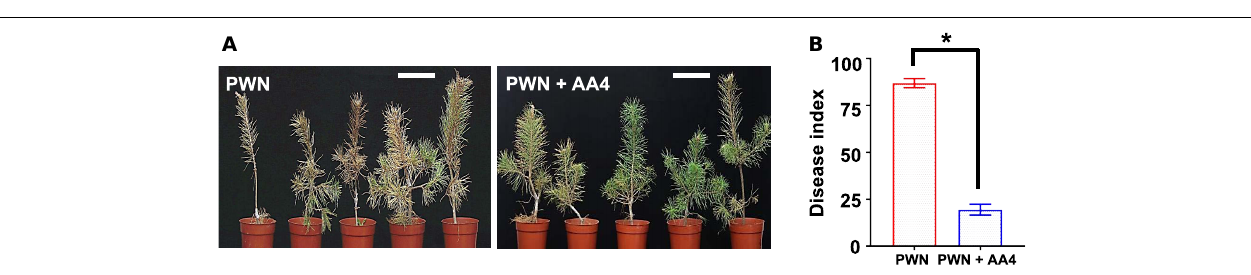
We next created a knock-out mutant of the sdaB gene by employing the Red ( λ , β , exo)-mediated DNA homologous recombination system. The L -serine hydrolase activity of the sdaB gene knock-out deletion mutant AA4 (cid:49) sdaB was significantly lower than that of the wild-type AA4 or the AA4 (cid:49) sdaB mutant strain complemented with the sdaB wild-type gene ( Figure 5B ), which indicated that the interruption of the sdaB gene affected the biosynthesis of L -serine dehydratase. Then, we compared the PWN-killing activities of the wild-type AA4 and AA4 (cid:49) sdaB by using the fluorescent staining-based nematocidal detected in the worms treated with AA4 (cid:49) sdaB cells or their the miniTn10 insertional mutant. Complementation of